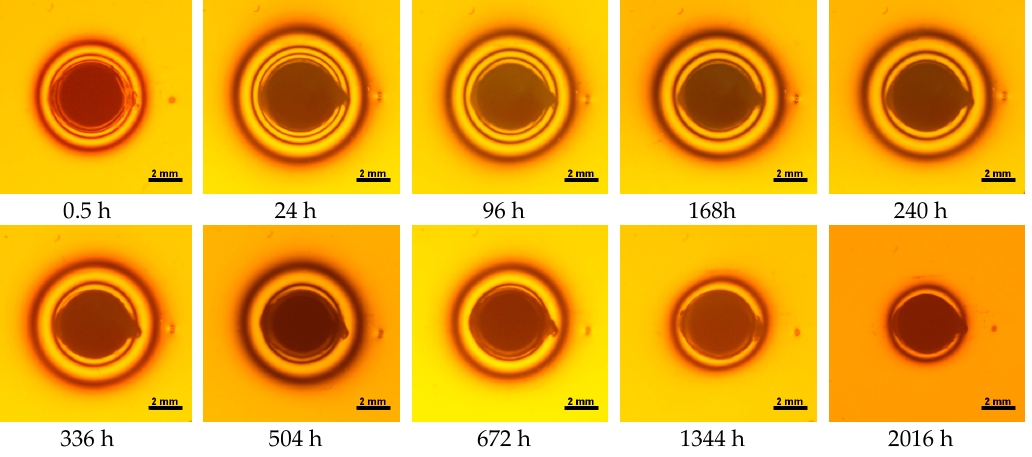
Figure 16. Isochromes in an epoxy plate around NX3 restoration before and after water storage; 0.5–2016